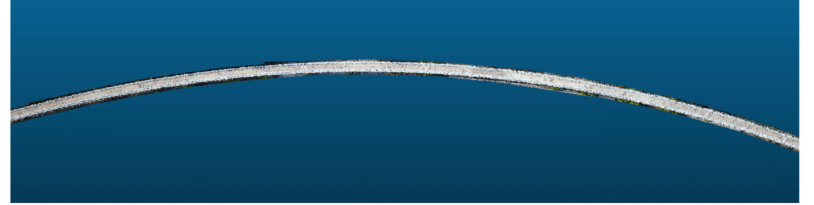
Figure 13. Illustration of the dense point clouds of the magnetic floating turning structure.